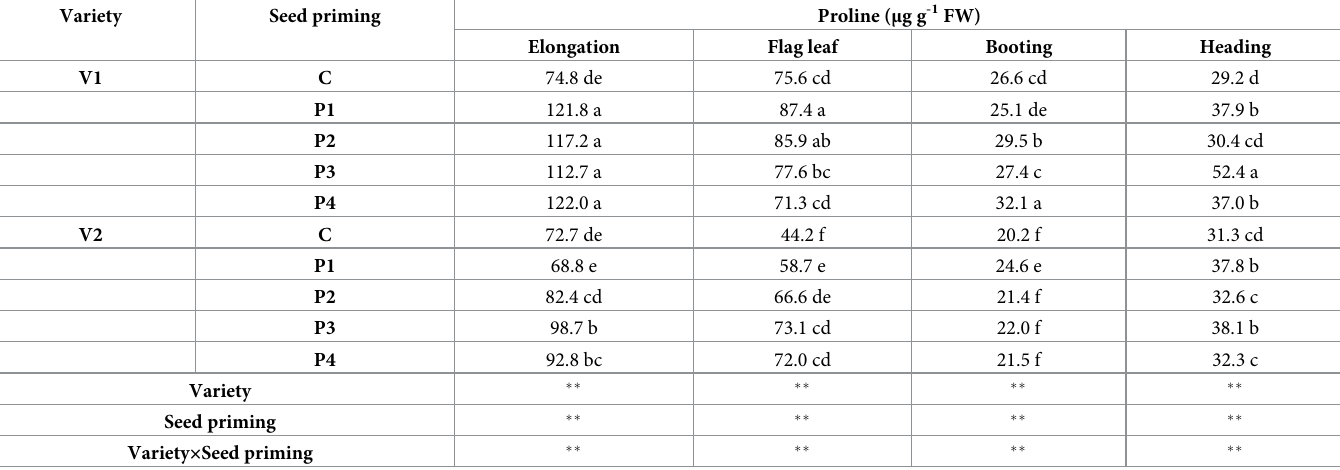
Table 3. Effects of seed priming on proline of sorghum under salt stress at different growth stages. Variety